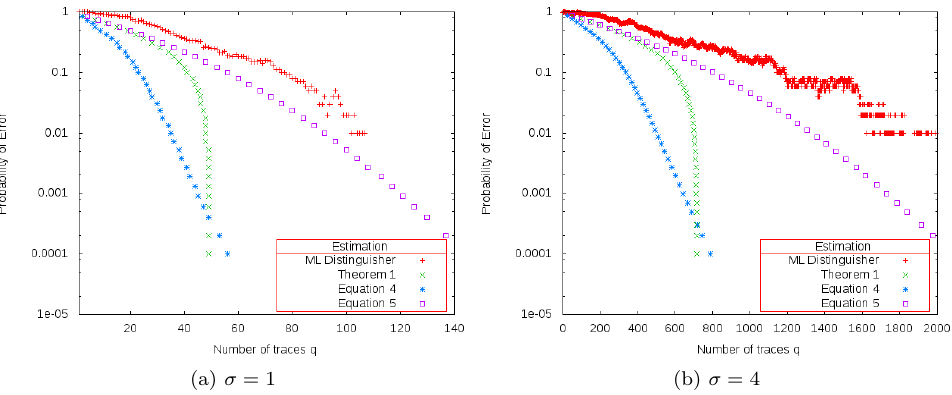
Figure 5: Error rate for a monobit leakage in a logarithmic